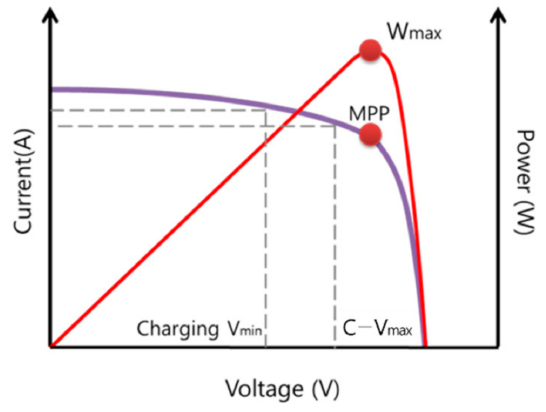
Figure 1. I–V curve of Solar